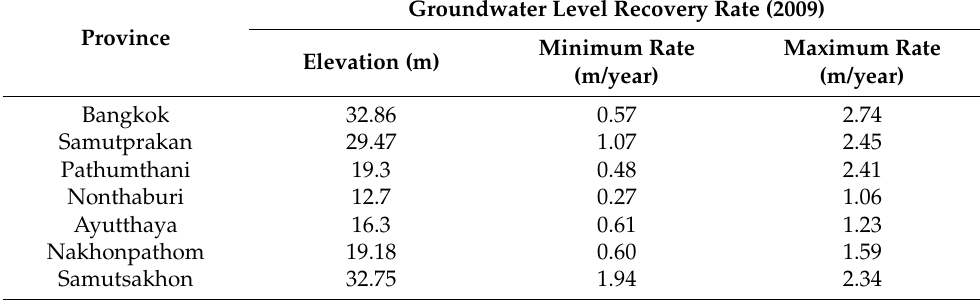
Table 1. Groundwater level situation at each borehole.